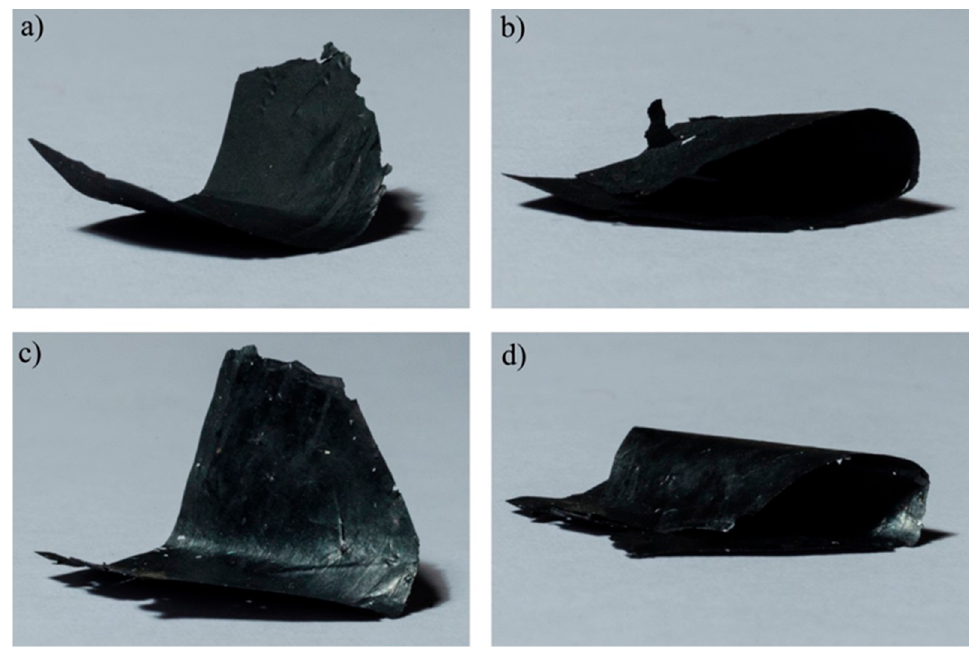
Figure 1. Photographs of free-standing nanopapers (diameter 40 mm): ( a ) RGO nanopaper; ( b ) RGO nanopaper bent 180°; ( c ) RGO_1700 nanopaper; ( d ) RGO_1700 nanopaper bent 180°.